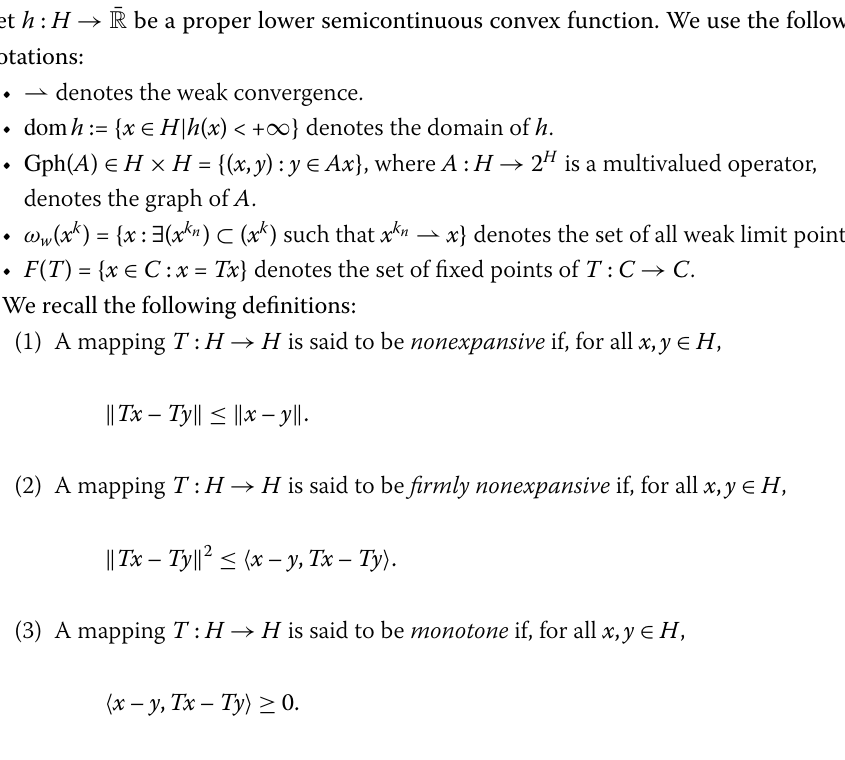
Algorithm 1.3 Given x 0 ∈ dom A and α k ∈ (0,+ ∞ ),